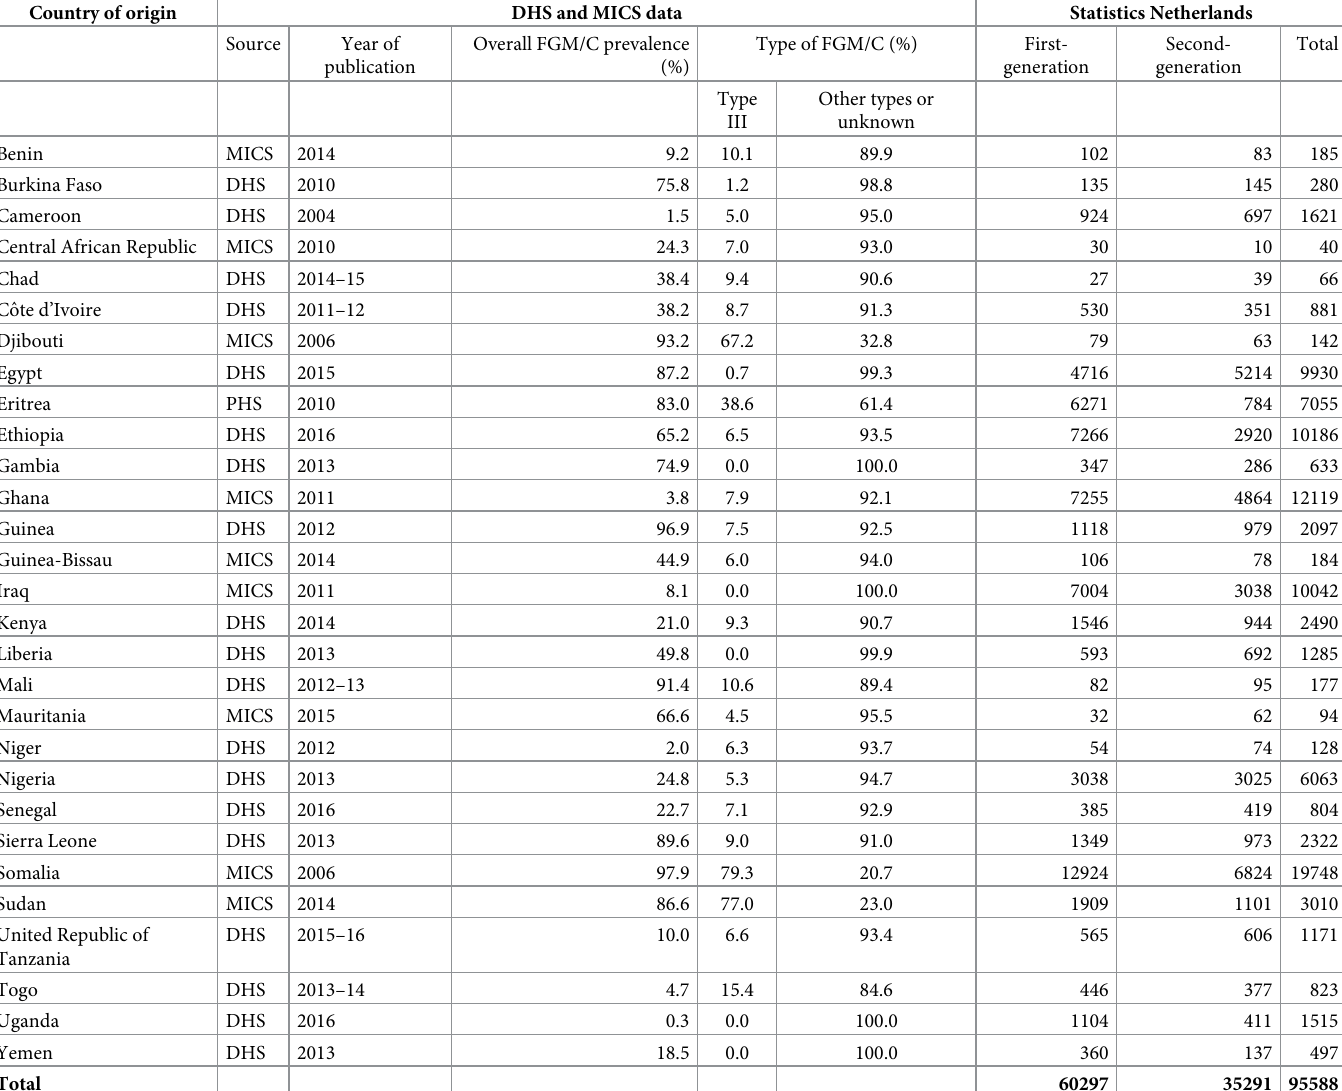
Table 1. DHS and MICS data: Country of origin, source- and year of publication, overall prevalence (%) and the prevalence of Type III and other types of FGM/C (%); Statistics Netherlands dataset on first- and second-generation female migrants. Country of origin